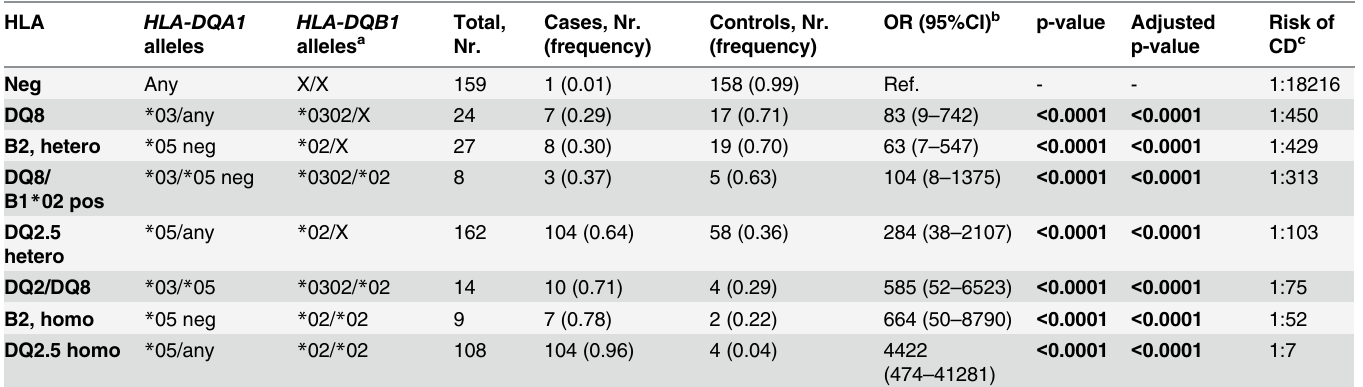
Table 2. HLA haplotype and CD